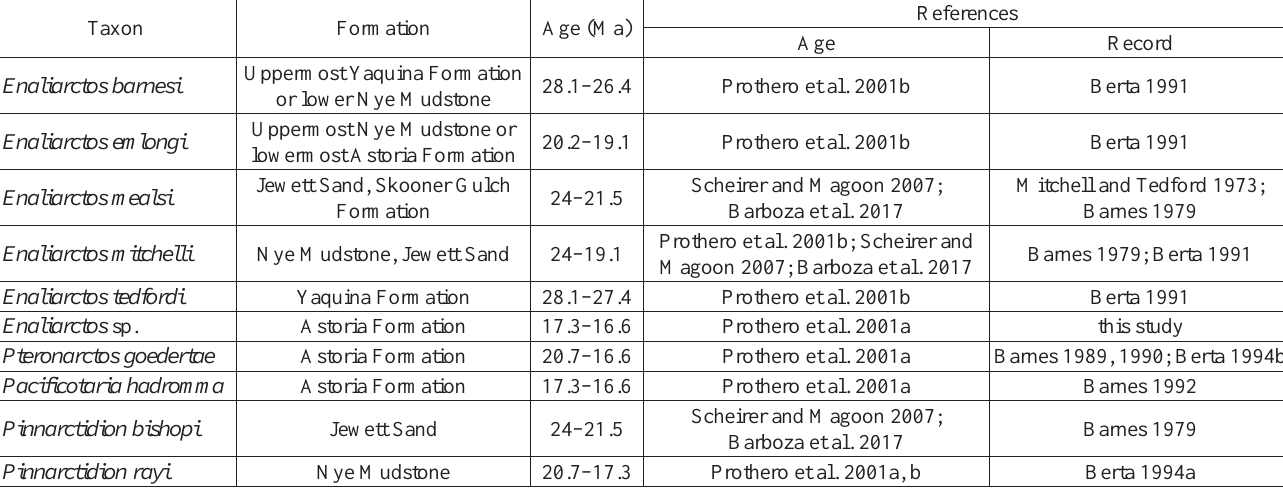
Table 3. Fossil occurrences and geochronologic age control for enaliarctine